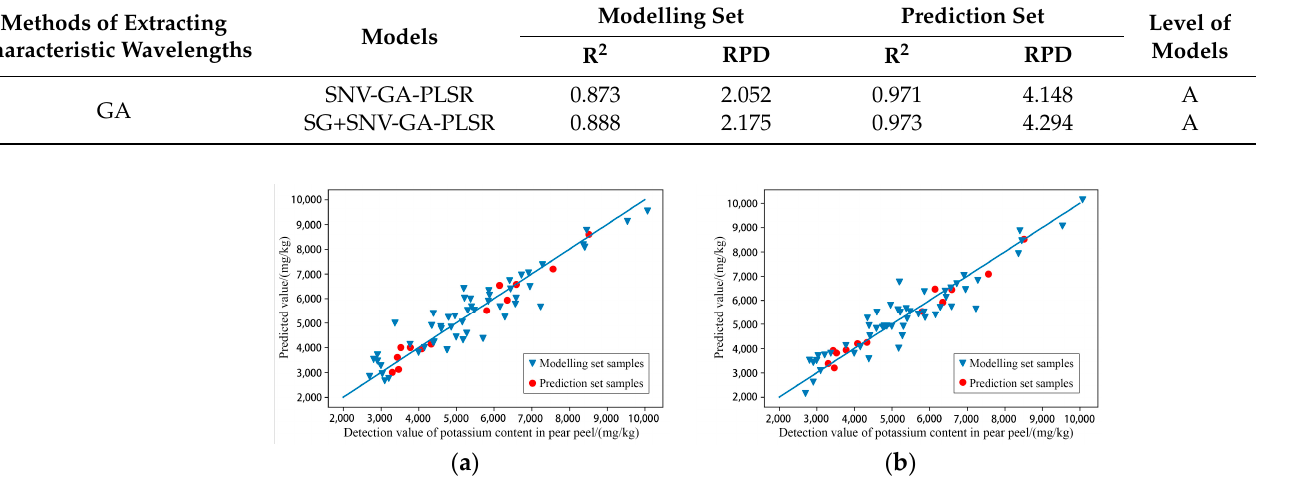
Figure 17. Scatter plots of models’ prediction results of the content of potassium in pear peel sam- ples. ( a ) SNV-GA-PLSR; ( b ) SG+SNV-GA-PLSR. Table 9. Modelling prediction results of the content of potassium in pear peel based on the selected characteristic